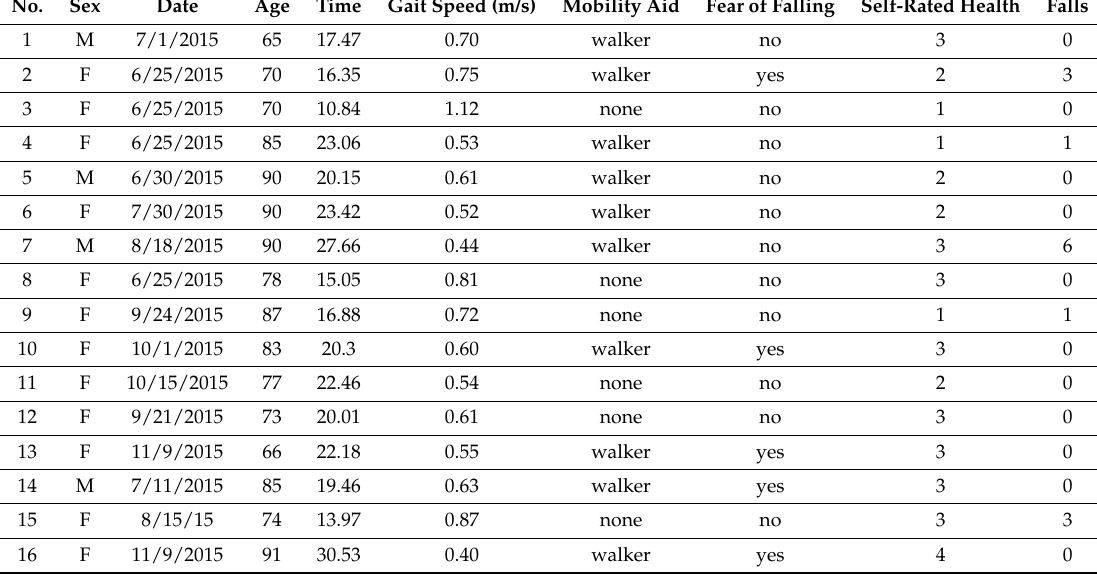
Table 2. Demographic data, gait speed, and fall